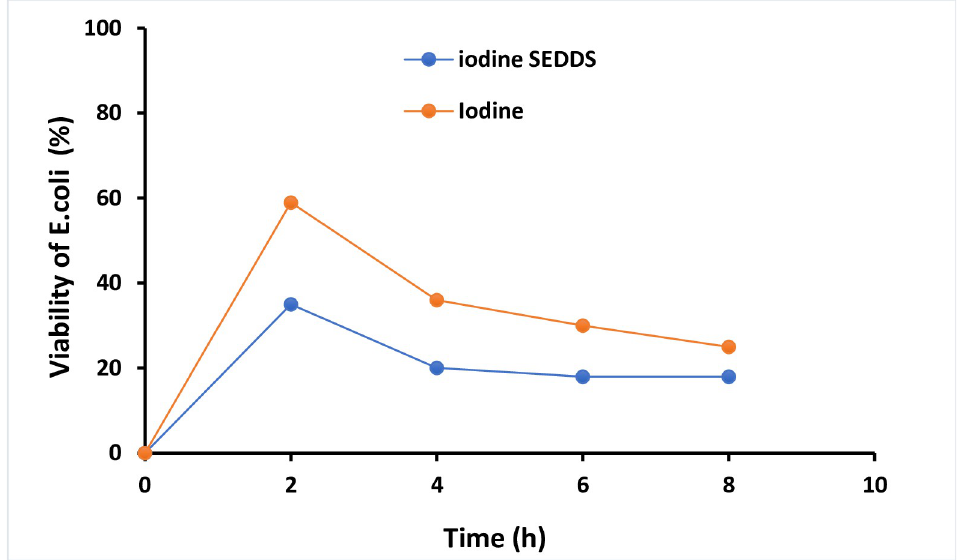
Fig 6. Percentage viability of microorganisms over the time period of 8